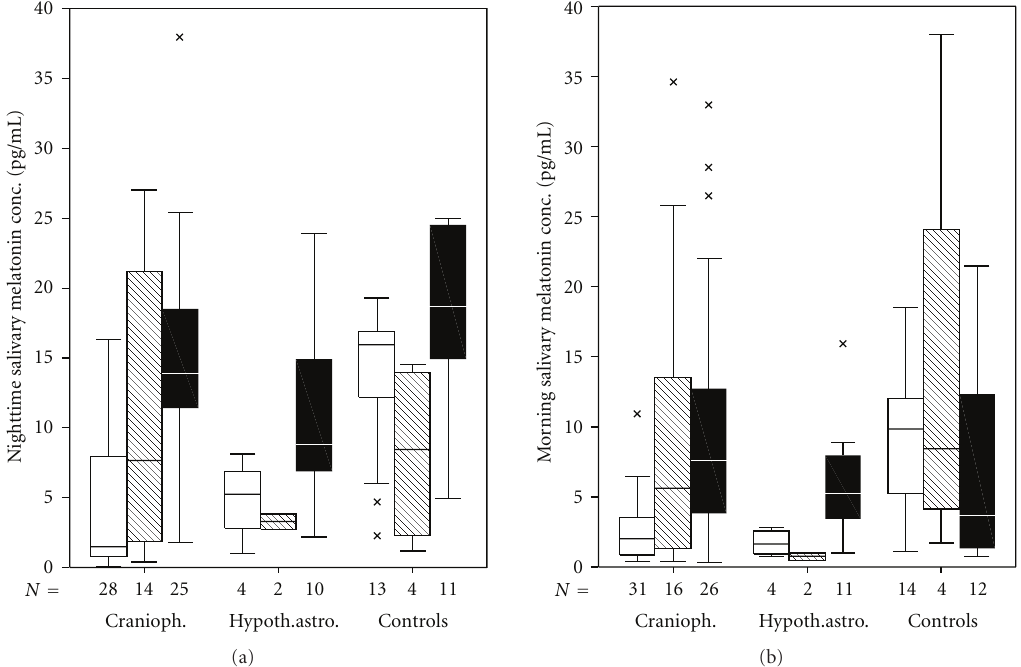
Figure 2: Salivary melatonin concentrations at nighttime (a) and in the morning (b) in patients with childhood craniopharyngioma, hypothalamic pilocytic astrocytoma, and controls in relation to the degree of obesity (body mass index [BMI] < 2 SD [filled black boxes], BMI 2–4 SD [hatched gray boxes], or BMI ≥ 4 SD [open boxes]). The horizontal line in the middle of the box depicts the median. Edges of the box mark the 25th and 75th percentile. Whiskers indicate the range of values that fall within 1.5 boxlengths. Values more than 1.5 box-length from the 25th and 75th percentiles are marked by an asterix. (Modified from [5], with the kind permission of Endocrine Press.)